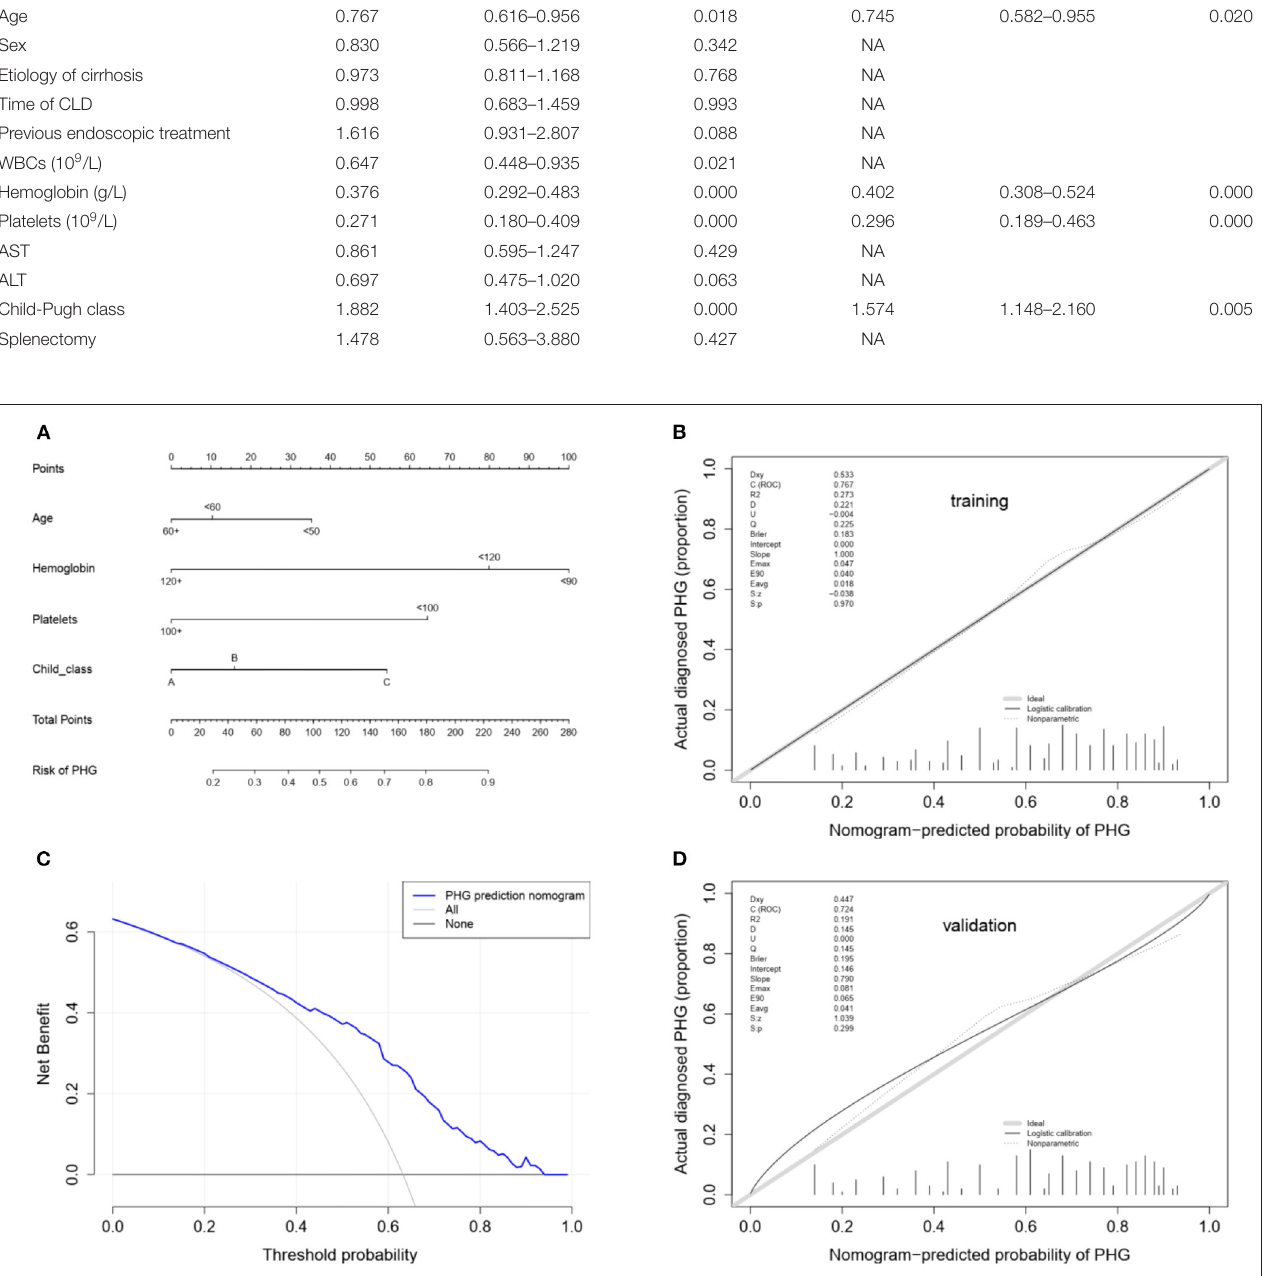
FIGURE 3 | (A) Nomogram for the prediction of PHG probability in LC patients. In the nomogram model, the patient’s score for each value is located on each variable axis, and a vertical line is drawn upward to determine the number of points received for each variable value. The sum of all variables located on the total points axis and a line drawn downwards to the risk axes are used to determine the probability of the the presence of PHG. (B) Calibration using the training cohort. The x-axis represents the predicted probability and the y-axis represents the observed fraction obtained through gastroscopy. Points below the ideal line represent over-prediction, and those above represent under-prediction. The calibration line indicates nomogram performance. (C) Decision curve analysis. The y-axis represents the net benefit. The blue line represents PHG risk, the thin solid line represents the assumption that all patients have PHG, and the thick solid line represents the assumption that none of the patients have PHG. (D) Calibration using the validation